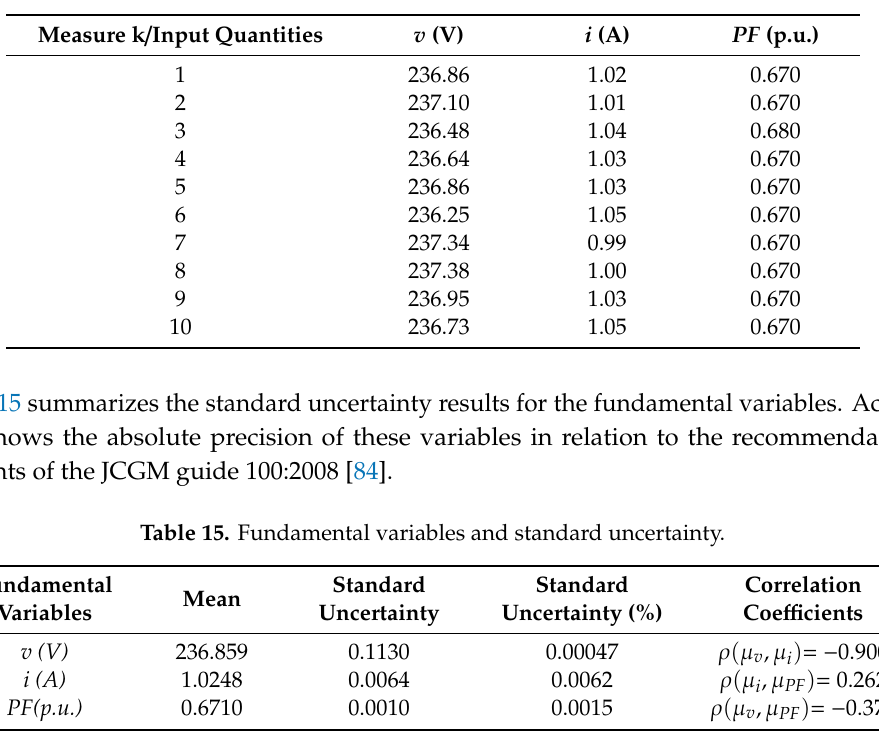
Table 14. Fundamental variables: input quantities from 10 sets of simultaneous observation.